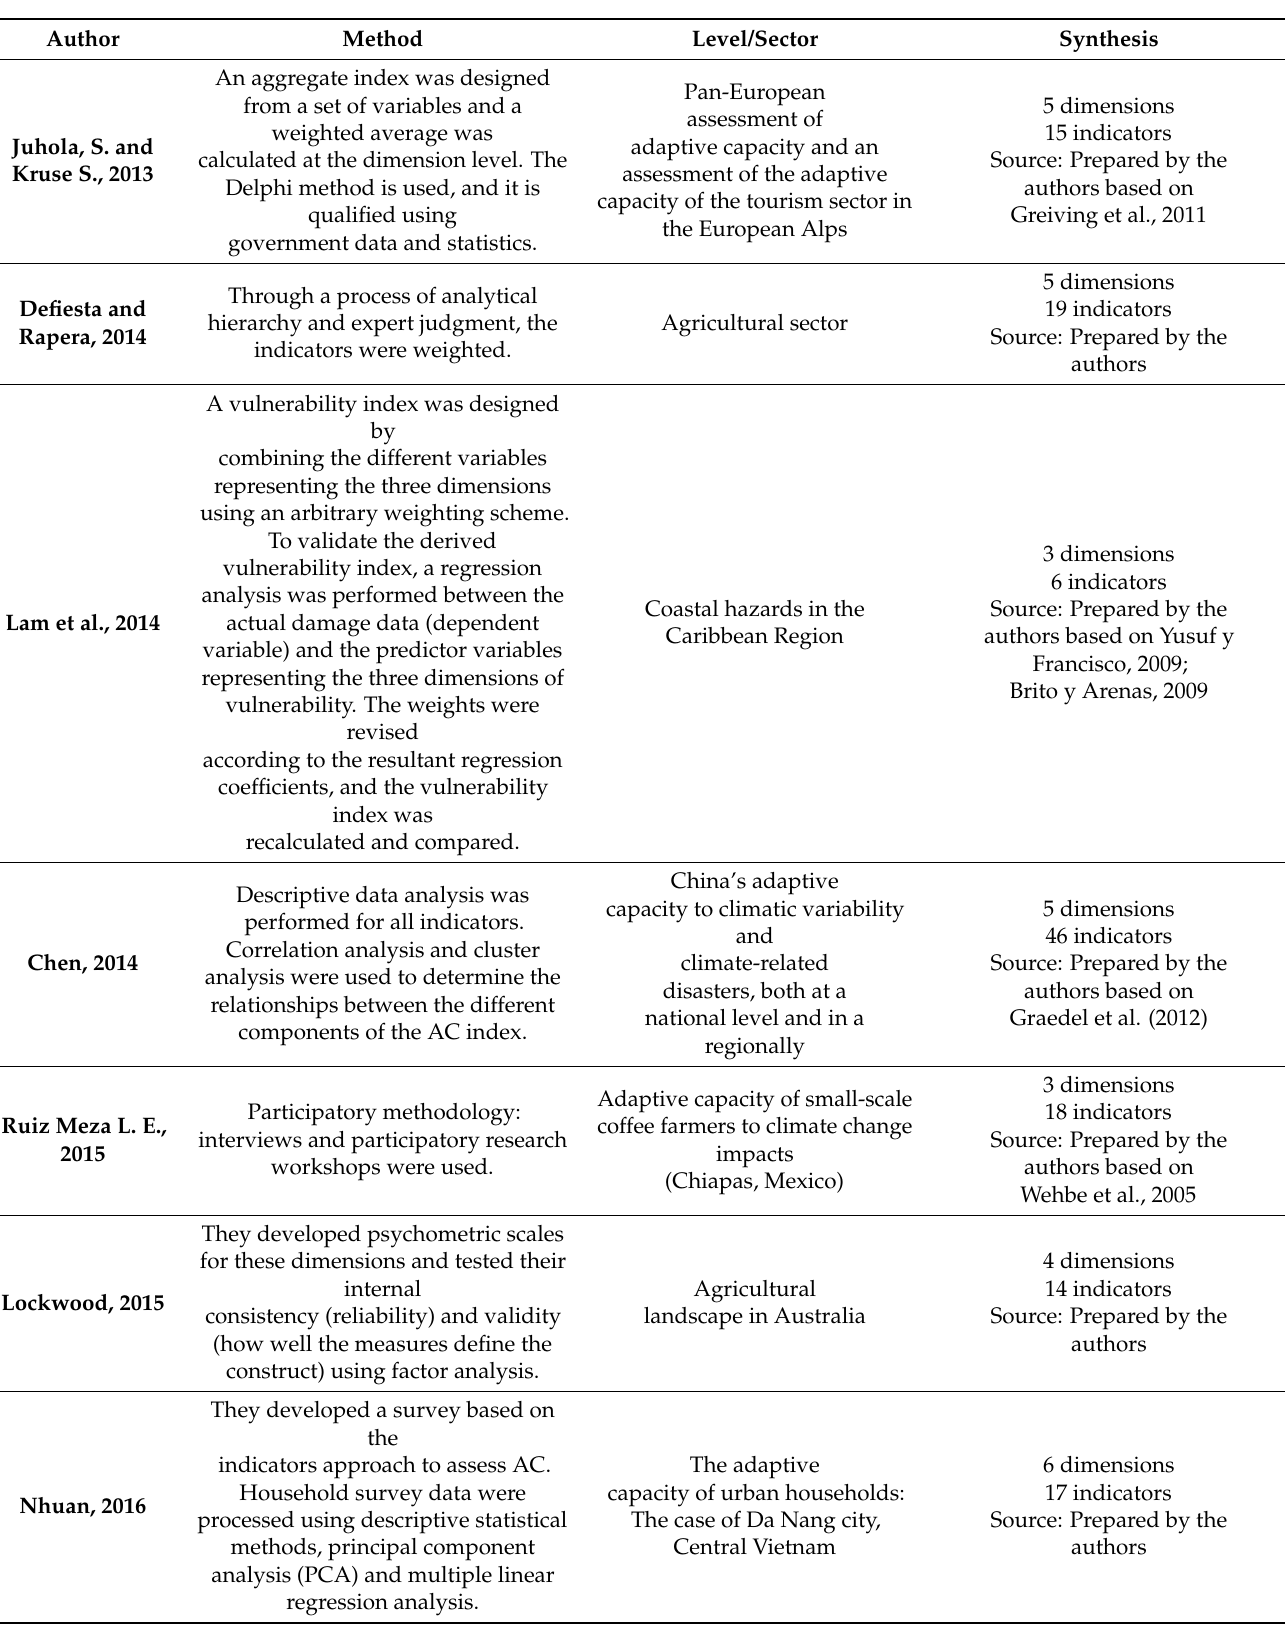
Table 1. Summary of the most relevant information about the 20 studies analyzed